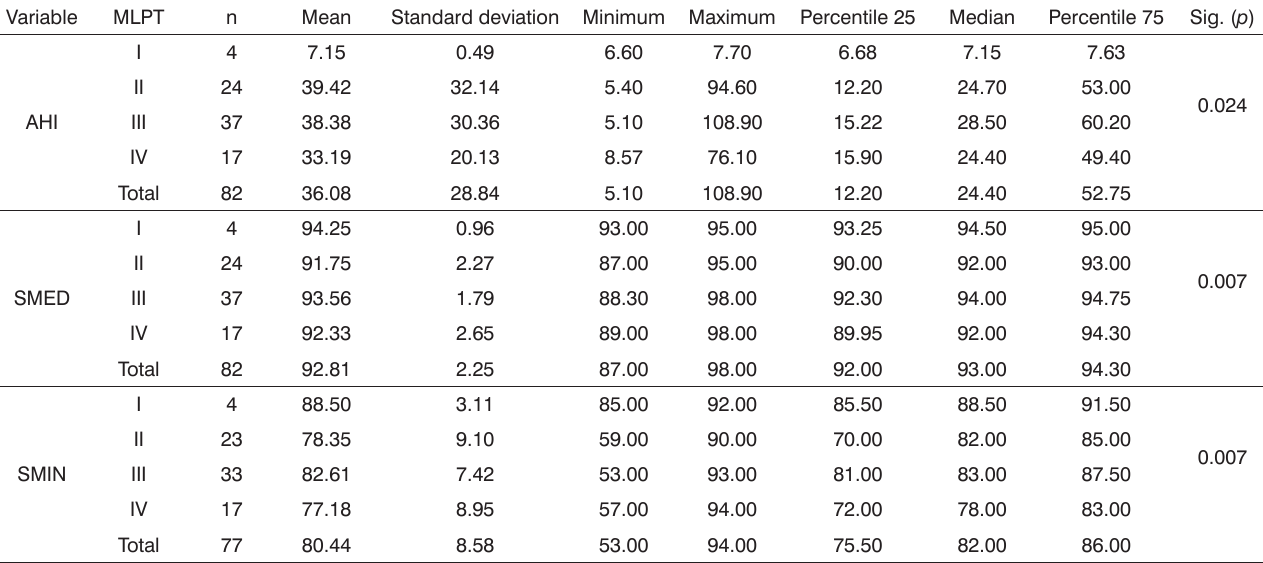
Table 4. Correlations among the modified Mallampati index and polysomnography parameters.